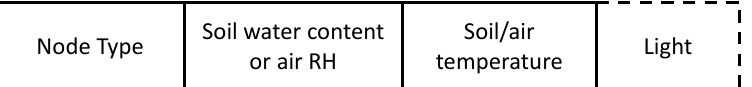
Figure 6. Packet structure.